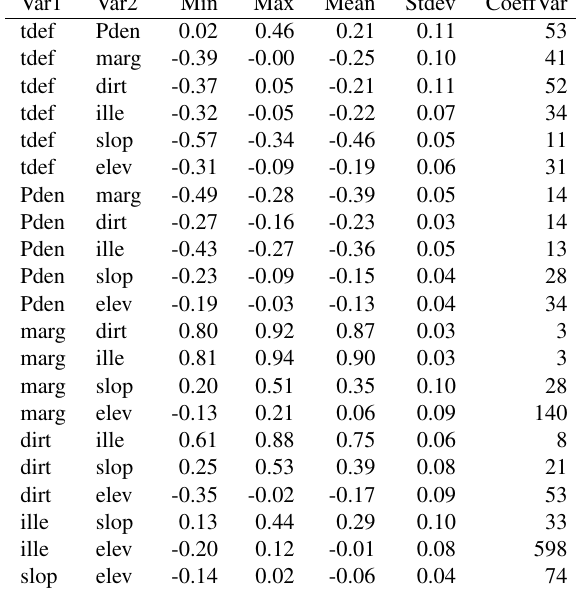
Table 2: Minimum, maximum, mean, standard deviation and co- efficient of variation of the values of the Pearson coefficient of correlation with 140 units (zoning